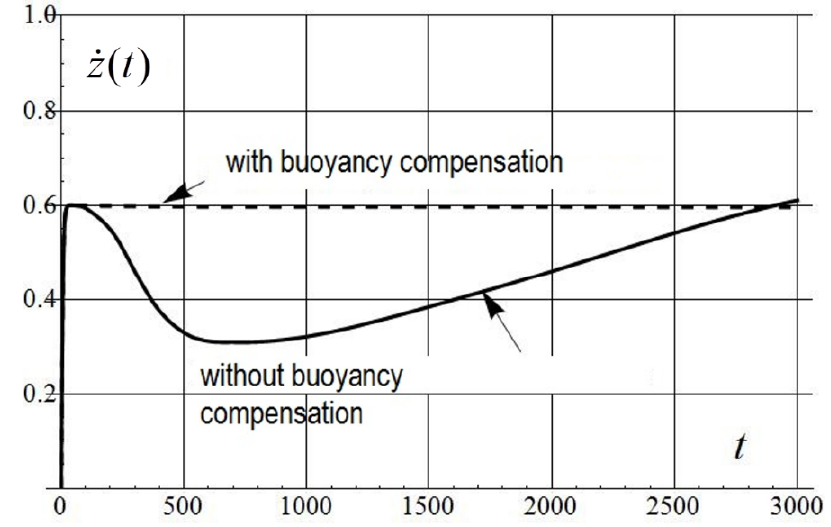
Figure 30. Speed of submersion versus time with and without compensation of the replacement volume: equatorial waters, steel cylinder, l ∗ = l c = 2, η =